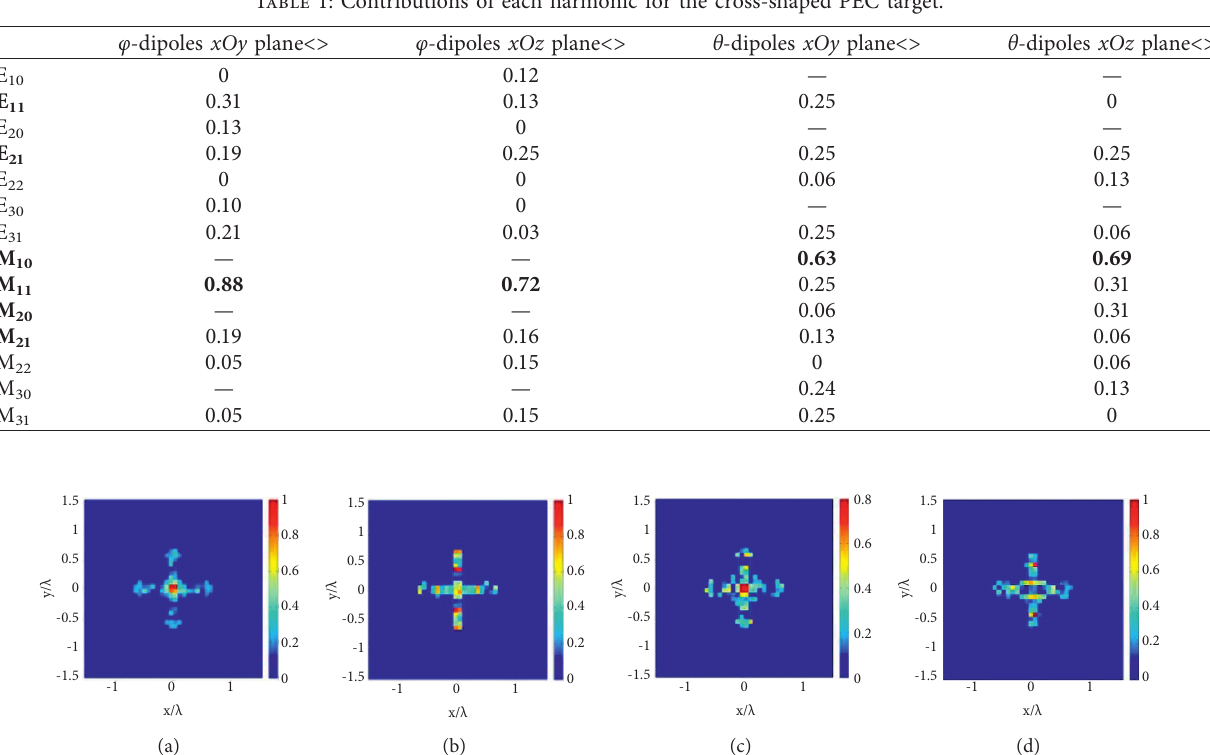
Figure 5: Cross-shaped PEC target images obtained using dominant harmonics. (a) xOy plane and φ -oriented dipoles, (b) xOz plane and φ -oriented dipoles, (c) xOy plane and θ -oriented dipoles, and (d) xOz plane and θ -oriented dipoles. The adopted signal-to-noise ratio was SNR � 10dB. Table 1: Contributions of each harmonic for the cross-shaped PEC target.